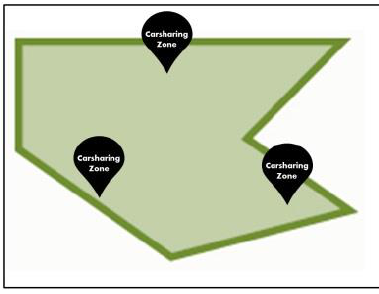
Figure 3. Carsharing free-floating one-way (Source: